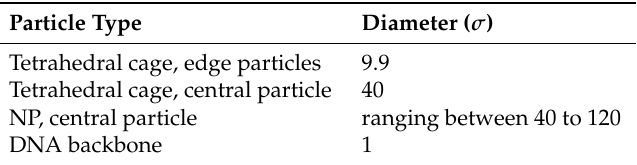
Table 2. The particle diameter for excluded volume interactions given by Equation (2). For details about the interactions between DNA sites see ref.